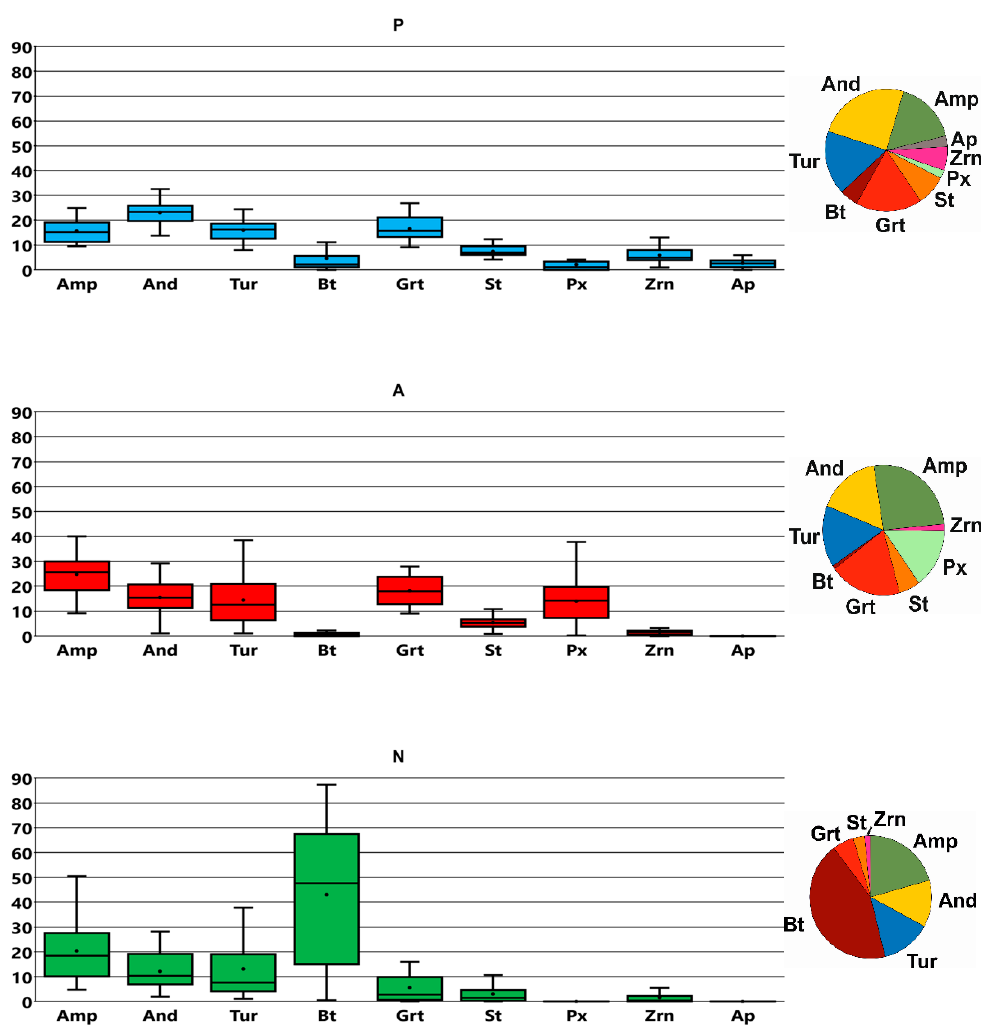
Figure 4. The heavy mineral transparent frequencies for each studied area (bar chart P—Porto; bar chart A—Aveiro; bar chart N—Nazar é ) of specimens with more than 1% of mean frequency (Table 2). The box-plots represent the 25th and 75th quartiles. The horizontal line represents the 50th quartile (median). The small dots represent the mean value for each mineral. The extremes of each box vertical line represent the maximum and minimum values. Each pie chart next to the right of each bar chart represent the average frequency values of each mineral.